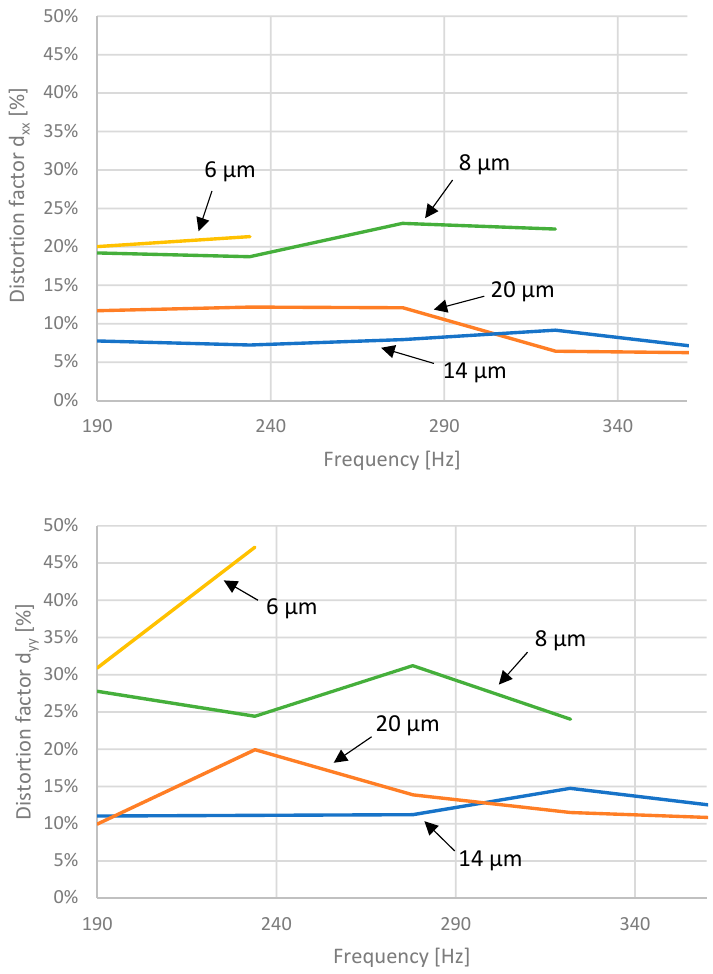
Figure 15. Distortion factors of tests at different displacement amplitudes (6–20 µ m); 11.1 N static load.